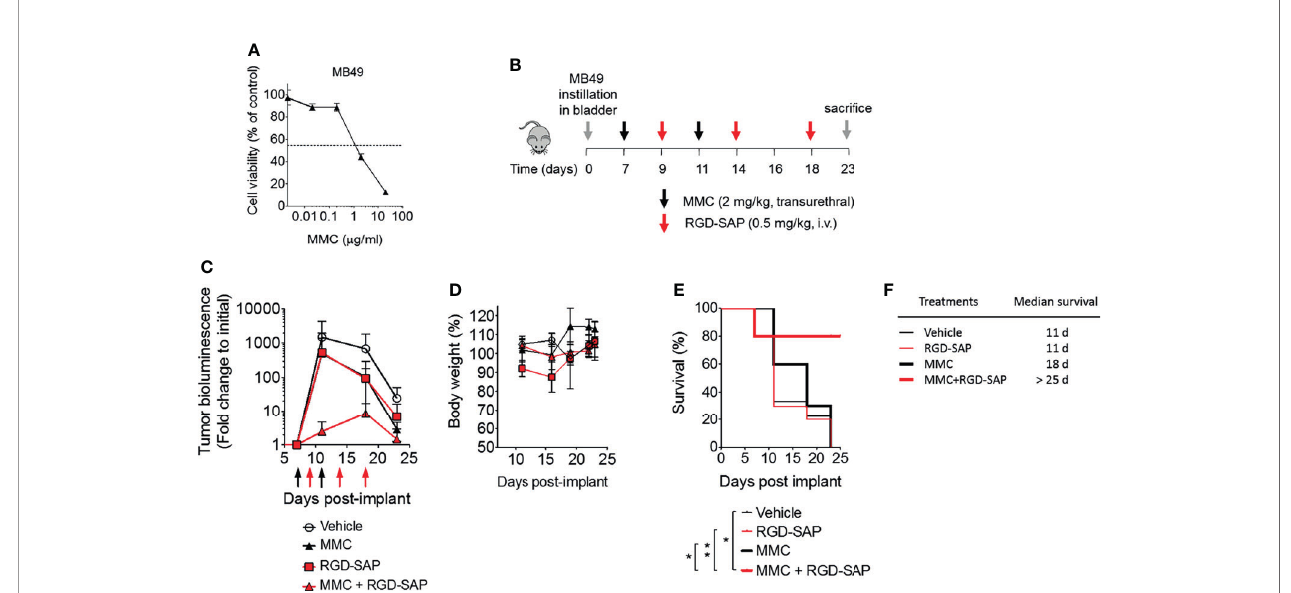
FIGURE 7 | Effects of MMC and RGD-SAP on tumor growth in an orthotopic syngeneic bladder cancer mouse model. (A) Effect of mitomycin C (MMC) on MB49 murine bladder cancer cell line viability as measured by MTT assay. (B) Schematic representation of the in vivo experimental design and treatment schedule. Luciferase- expressing MB49 cells were transurethrally injected into the bladder of 7-week-old C57BL/6 female mice. Tumor engraftment was monitored by in vivo bioluminescence imaging. Tumor bearing mice were randomized into 4 experimental groups and treated with the indicated dose of MMC (transurethral, black arrows, n=10 mice), RGD- SAP (i.v., red arrows, n=10 mice), MMC + RGD-SAP (n=5 mice) or vehicle (n=10 mice). The results of two experiments with 5 animals/group were considered and cumulated (C) Tumor growth (mean ± SD) as determined over time by fold change to the initial detectable bioluminescence. (D) Effect of treatments on the animal body weight change. Animal weights are reported as percent of starting body weight (mean ± SD of 5-10 animals per group). (E) Kaplan – Meyer plot of animal survival and (F) median survival time. Results from a Mantel – Cox two-sided log-rank test are shown when statistically signi fi cant (*p < 0.05, **p < 0.01) for MMC+RGD-SAP (bold red line) versus vehicle (thick black line, hazard ratio 7.19; 95% CI, 1.51 – 34.26) or MMC (bold black line, hazard ratio 5.96, 95% CI, 1.44-24.69) or RGD-SAP (bold red line, hazard ratio 0.15, 95% CI, 0.03-0.62).